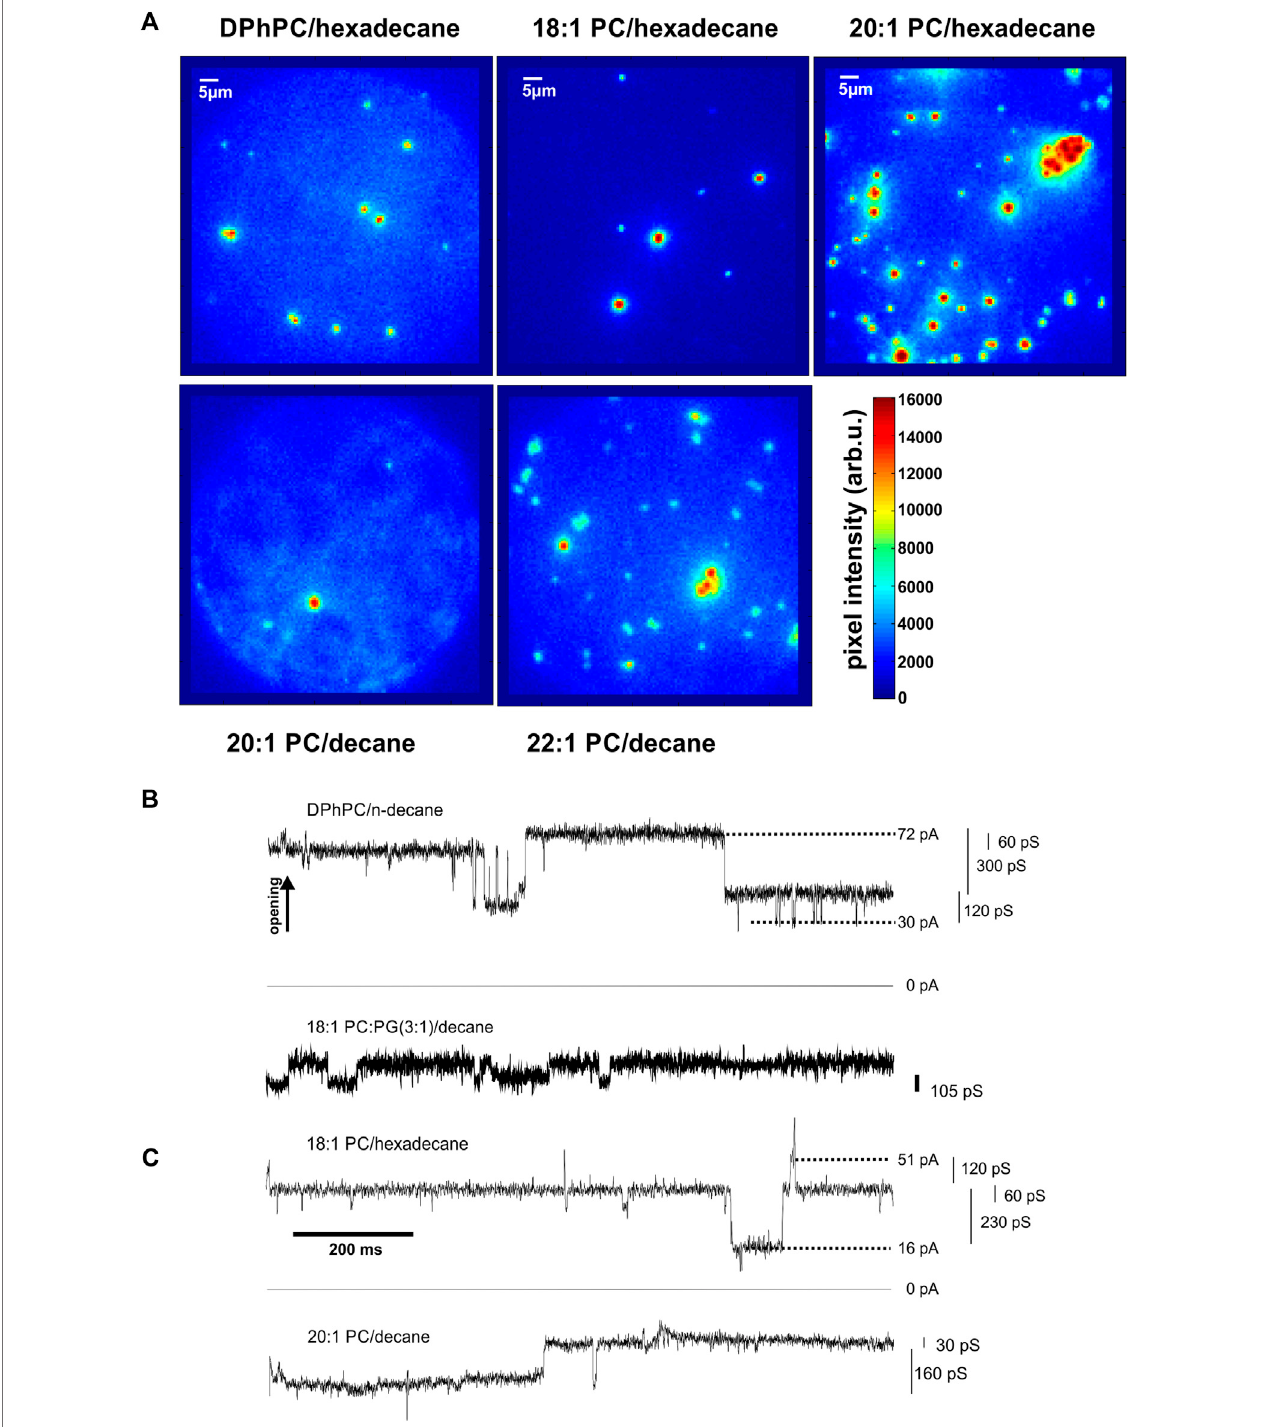
FIGURE 4 | KcsA clustering is observed for various thickness conditions. (A) , Images taken from top DPhPC/hexadecane bilayers ( left , n = 10), 18:1 PC/ hexadecanebilayers( middle , n =10),20:1PC/hexadecanebilayers( right , n =4)and bottom 20 – 1/decane( left , n =2)and22 – 1/decane( right , n =6).Whilechangingthe solvent between n-decane and hexadecane and varying the acyl chain length of the lipid bilayer, changes in bilayer thickness are expected. Since clustering was observed for all tested conditions, from about 30 Å to about 58 Å (Benz et al., 1975), it appears that hydrophobic mismatch does not occur or does not in fl uence signi fi cantly KcsA clustering in our experiments. Differences in number of clusters depend on total number of channels in the bilayers and showed no dependence on lipid/solvent combination. (B,C) , Coupled KcsA gating involving several channels. Cooperative activity involving several channels was observed in the presence of clusters in bilayers formed of b DPhPC/decane and 18:1 PC:PG (3:1)/decane; c di (18:1)-PC/hexadecane and 20:1PC/decane (N > 25).